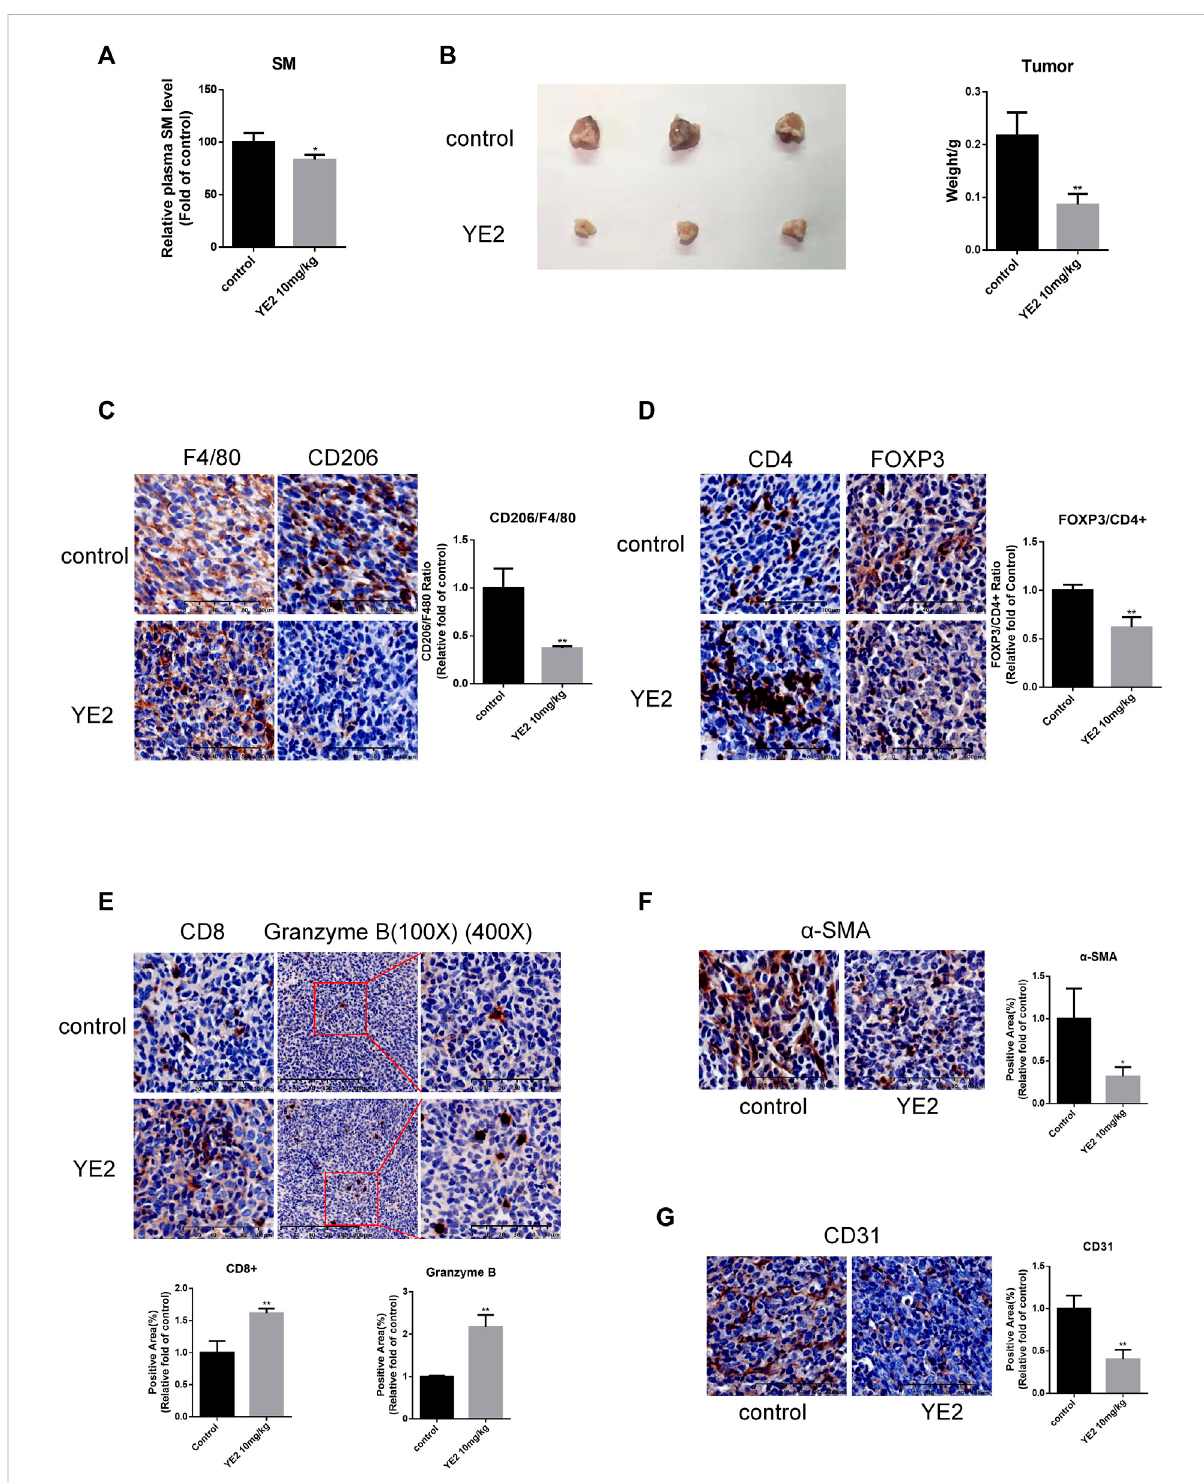
FIGURE 5 SMS2inhibitorinhibitsthegrowth ofPANC-02pancreaticorthotopic tumors invivo . (A) .Afterpre-administrationofSMS2inhibitorat10 mg/kg for2 weeks,bloodwastaken,andtheplasmaSMlevelwasmeasuredwiththeSMELISAkit. (B) .Tumortissueharvestedafter28 days. (C) .IHCanalysis of M2 macrophage in fi ltration in tumor tissues of control group and YE2 group. IHC representative graph and quanti fi cations of immune cells and components CD4, FOXP3/CD4 (D) , CD8, Granzyme B (E) , CAF ( α -SMA) (F) and vascular (CD31) (G) in fi ltration in tumor tissues. The results are shown as the mean ± SD. * p < 0.05; ** p < 0.01. (n = 5 mice/group). The observed fi eld is 200X zoom of original IHC